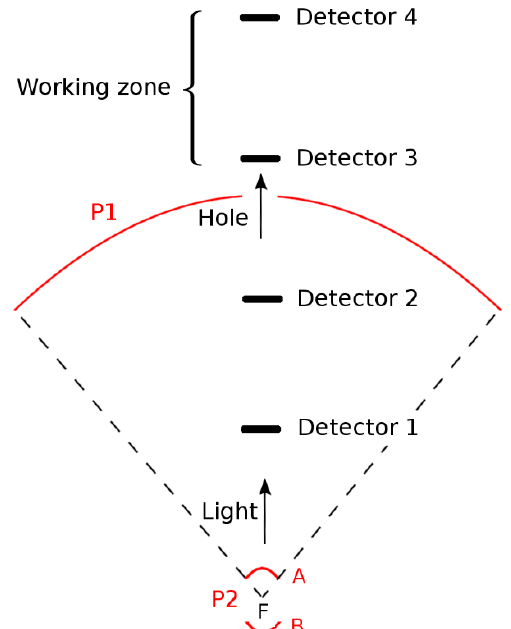
Figure 13. Double paraboloid device with four equally spaced detectors, to follow the evolution of the output beam from the P2 reflection until passage through the hole in paraboloid P1 and entering the working area, where the beam can be used.